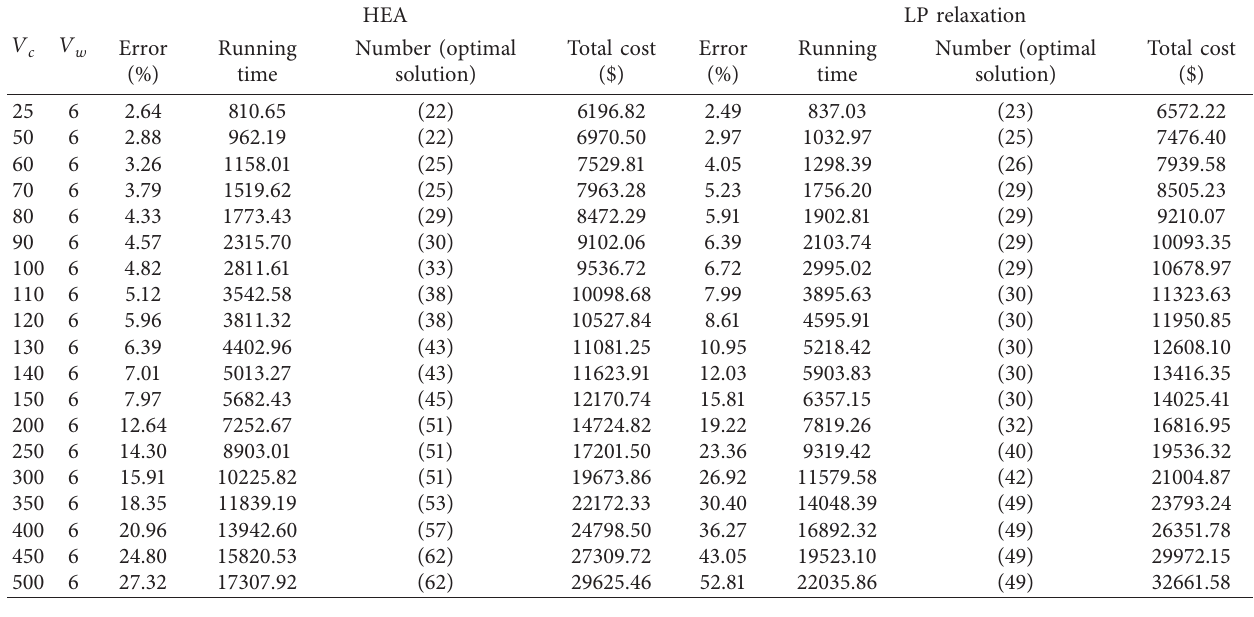
Table 6: Comparison results of HEA and LP relaxation.